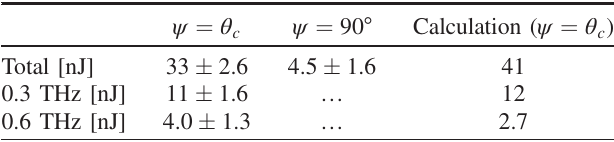
TABLE II. Absolute values of the intensities of a CChR pulse (calculated and measured with a power meter).